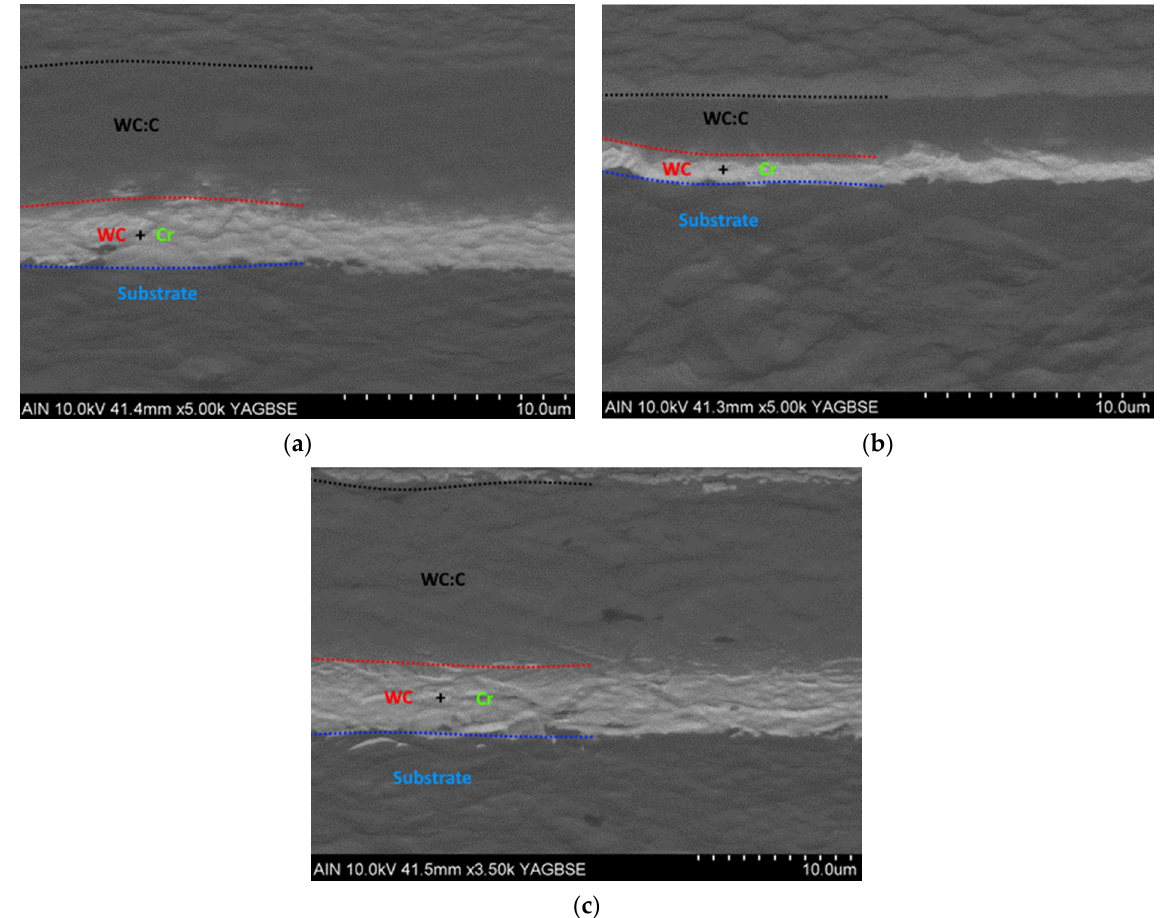
Figure 11. SEM cross-section showing the coating structure of ( a ) PIII + DLC WC:C 350 °C, ( b ) PIII + DLC WC:C 400 °C and ( c ) PIII + DLC WC:C 450 °C. From bottom to top, the images show the AISI 316L substrate with the Cr bonding layer, the WC interlayer and the W-doped coat.